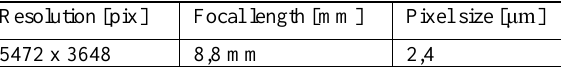
Table 2 . DJI Phantom 4 RTK camera main technical